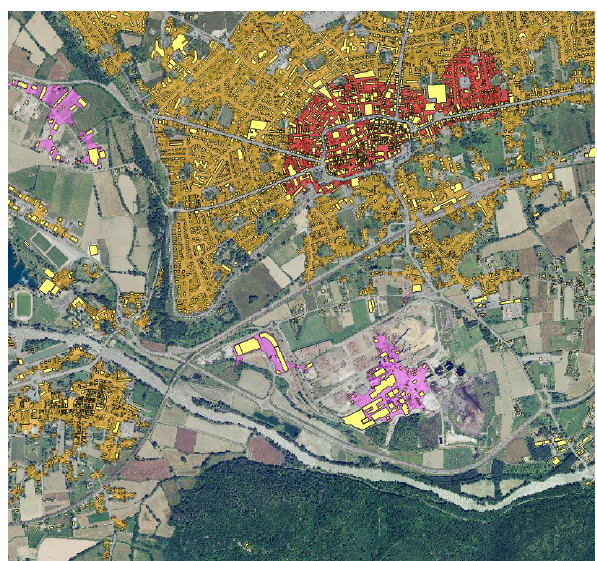
Figure 6. After refinement of urban classes: individual buildings from BD-Topo in yellow, Continuous Urban Fabric (CUF) in red, Discontinuous Urban Fabric (DUF) in orange and Industrial and Commercial Units (ICU) in